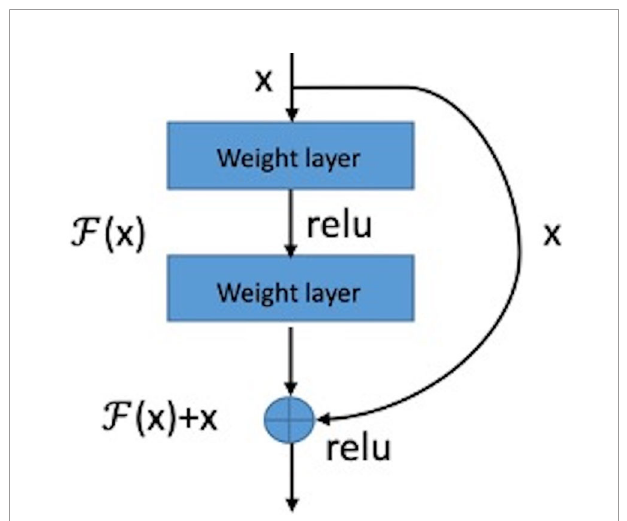
FIGURE 4 | Structure of a residual